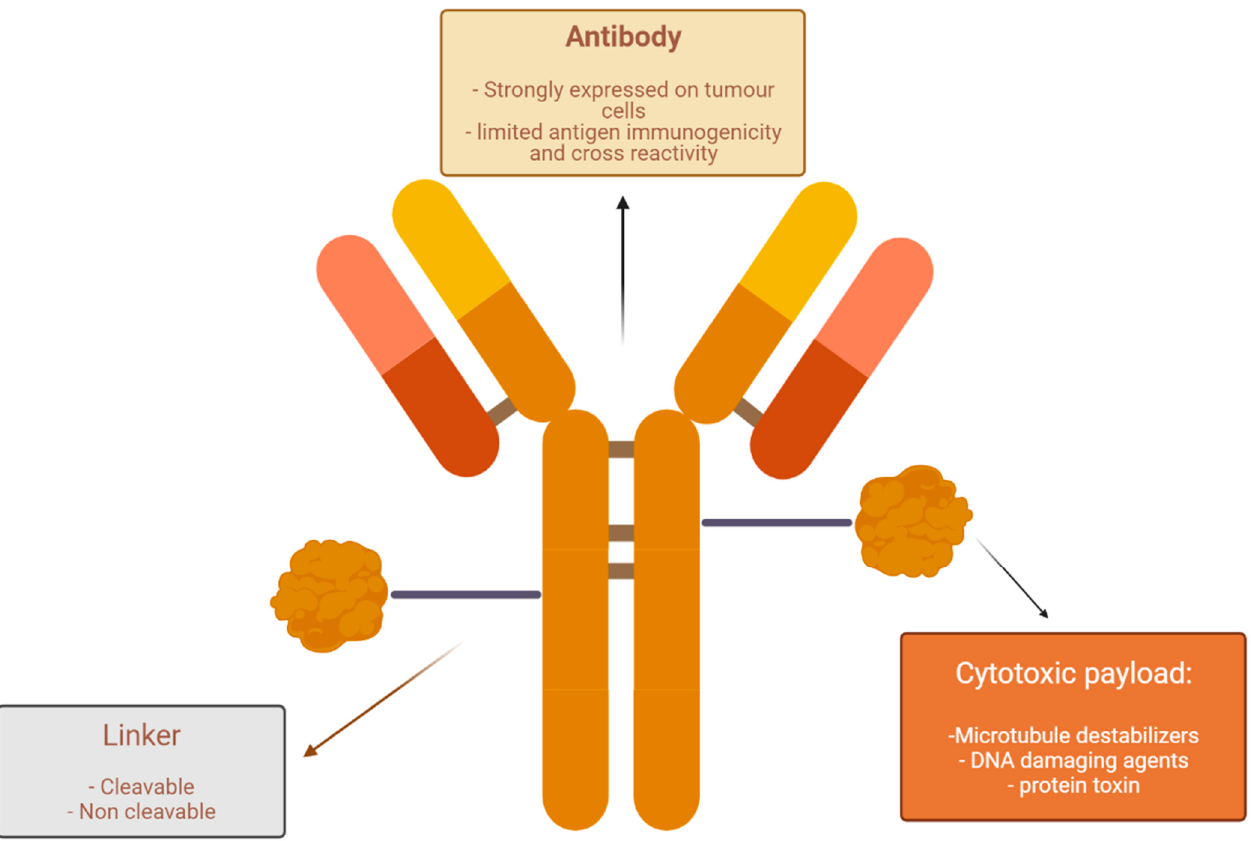
Figure 1. Structure and main functions of antibody-drug conjugate components .